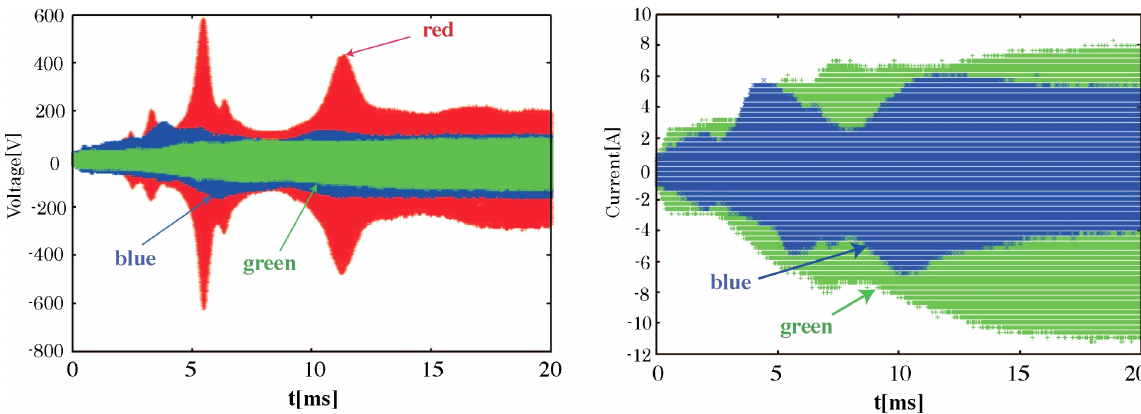
FIG. 13. Measurements of beam-induced voltages at the ends of coaxial cables (left) and the total currents of the two cables (right), when a beam with 3 . 11 × 10 13 (750 kW-eq) particles per bunch passes through the kicker. The red, blue and green lines show the results for (i) open circuit, (ii) diodes and 10 Ω resistors, and (iii) only 10 Ω resistors, respectively.